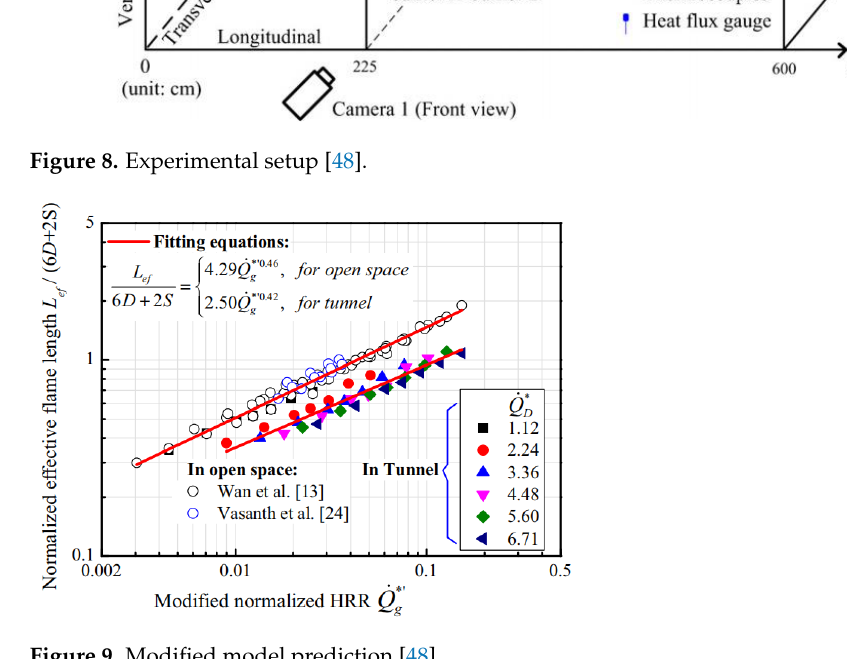
Figure 9. Modified model prediction [48].